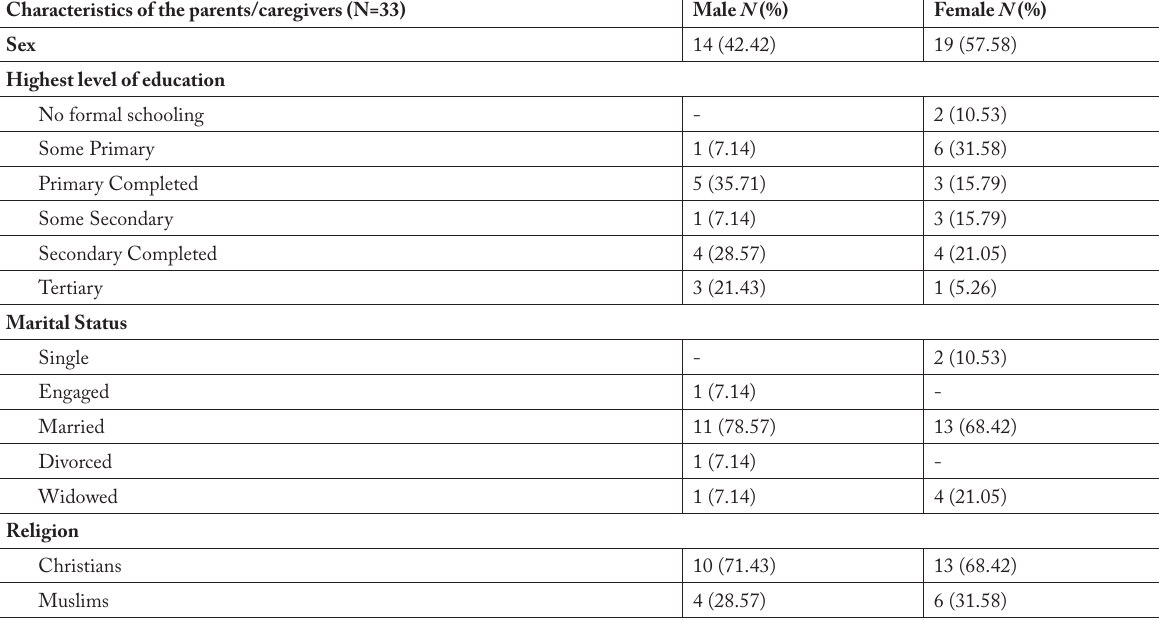
Table 2. Sociodemographic characteristics of parents/caregivers participating in the study, by sex ( N =